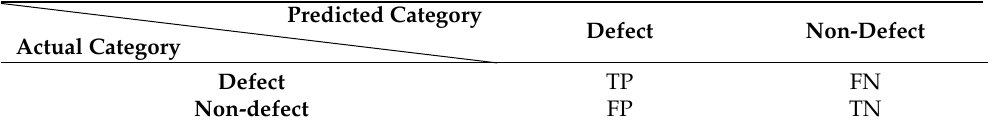
Table 1. Confusion